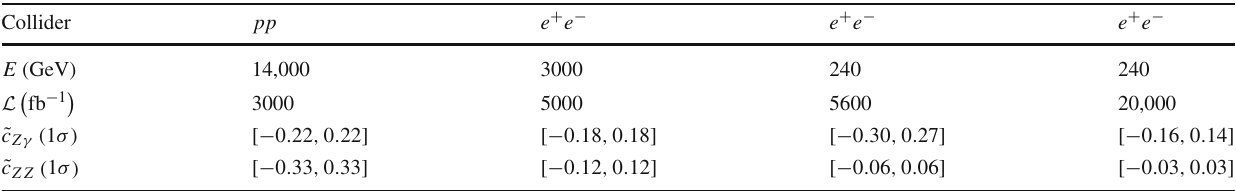
Table 3 Summary of 1 σ bounds on ˜ c Z γ and ˜ c ZZ from various analyses considered in our study, HL-LHC analysis, and CLIC analysis Collider